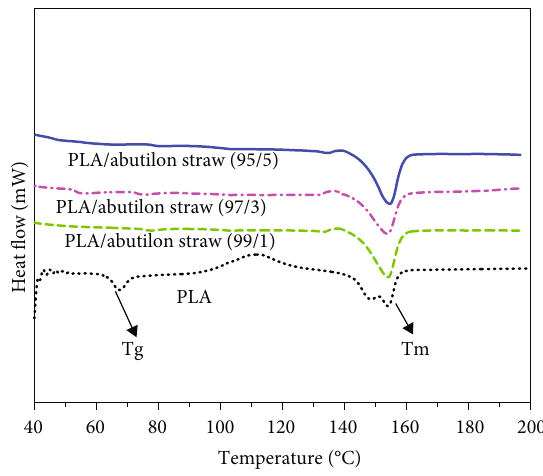
Figure 2: DSC curves of PLA and PLA/abutilon straw biocomposites.